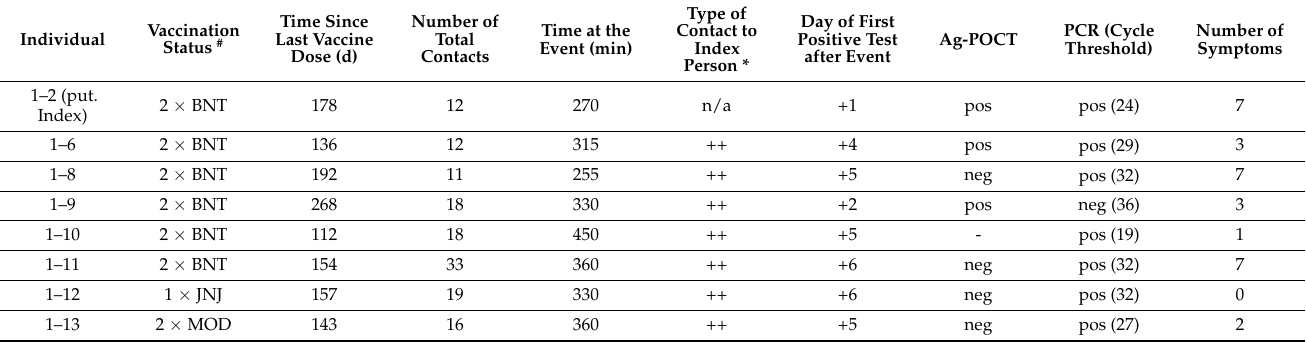
Table 3. Selected data for individuals who were